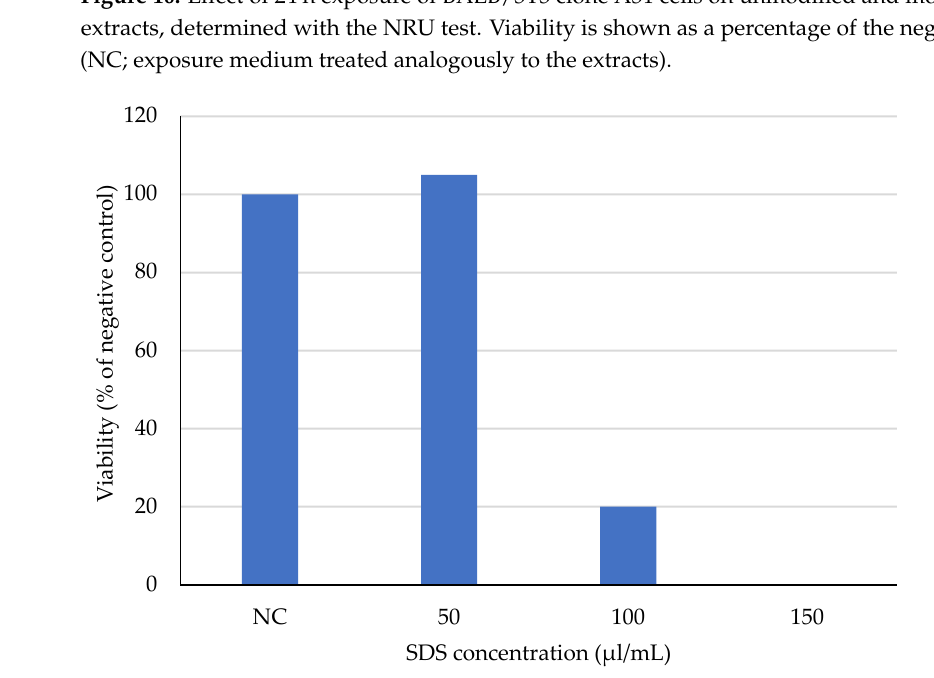
Figure 11. Viability of BALB/3T3 clone A31 cells exposed for 24 h to SDS (positive control), assayed with NRU test. Viability presented as a percentage of the negative control (NC; culture medium with vehicle, i.e., 2% H 2 O in culture medium).